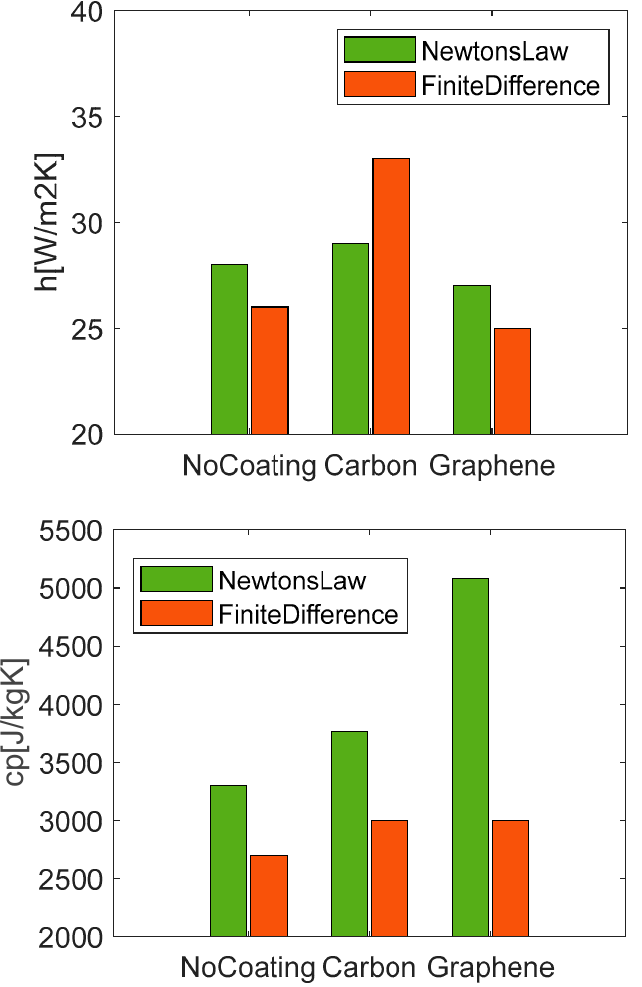
Figure 13. Estimated values of h and c p with Newton’s law and finite-differences method for different coating at discharge rate 0.5C.